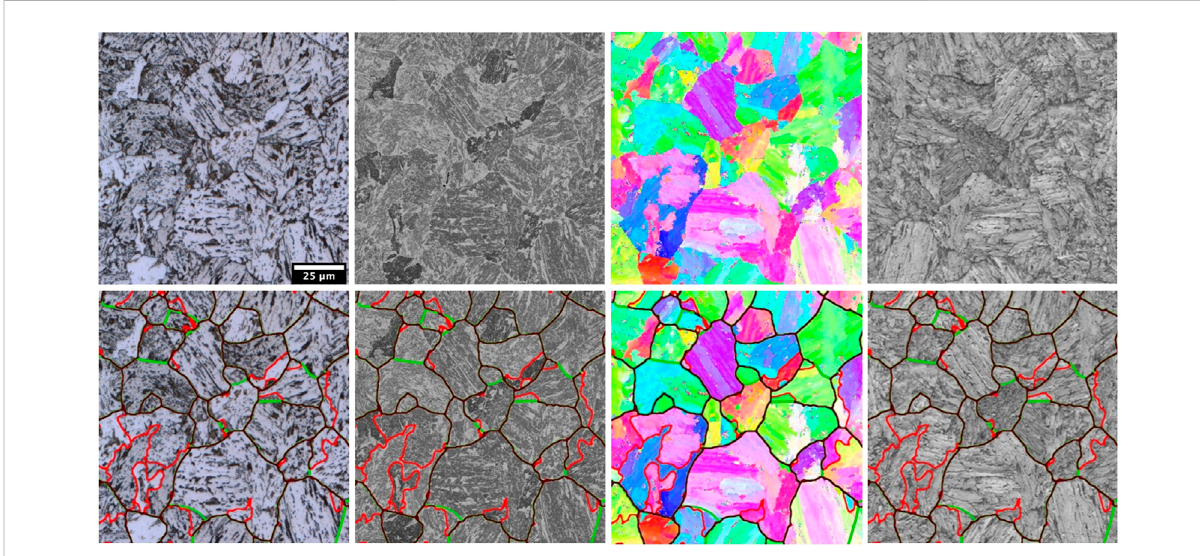
FIGURE 2 Overview of the different correlative data (left to right: LOM, SEM, IPF, IQ) with discrepancies (lower) between EBSD reconstruction (red) and manual annotation (green) and the overlapping sections between EBSD reconstruction and manual annotations (black).